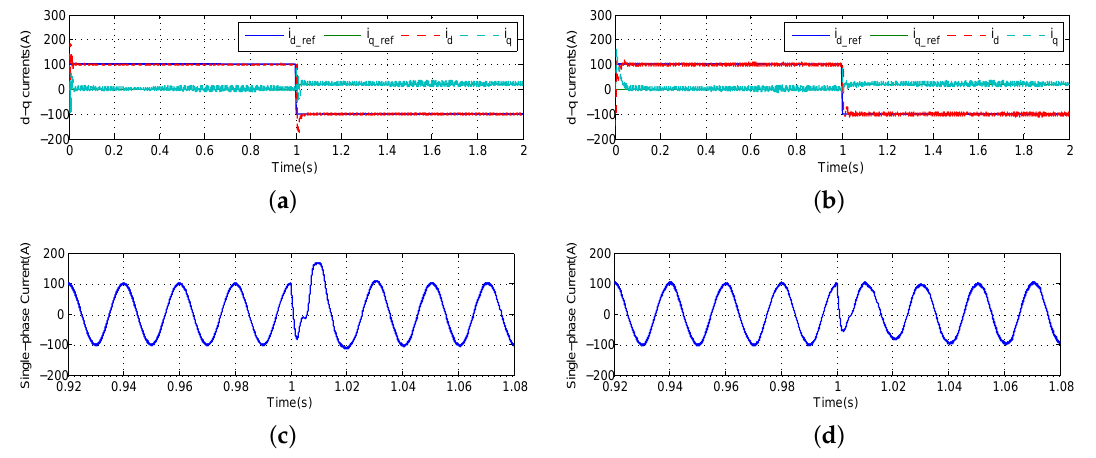
Figure 10. Comparisons for L filter-based GCC. ( a ) Conventional vector control: d - q currents; ( b ) NN vector control: d - q currents; ( c ) conventional vector control: single-phase current; ( d ) NN vector control: single-phase current.